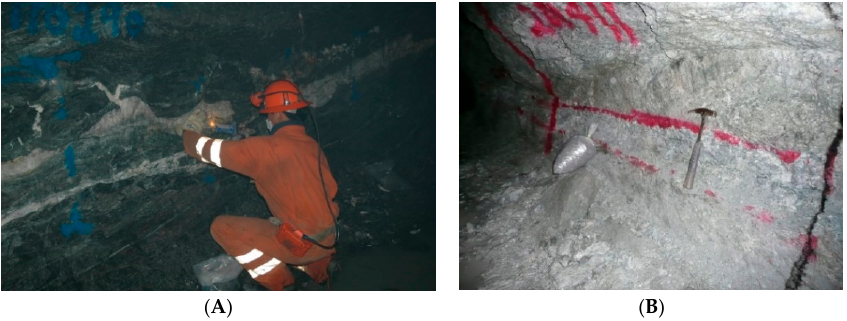
Figure 2. ( A ) Chip-channel sampling. Samples collected from sidewall of shanty drive. Each sample comprises near continuous chips collected across the vein; ( B ) Hand channel sampling of side walls. Table 8. Likely sampling errors during the collection of chip or chip-channel